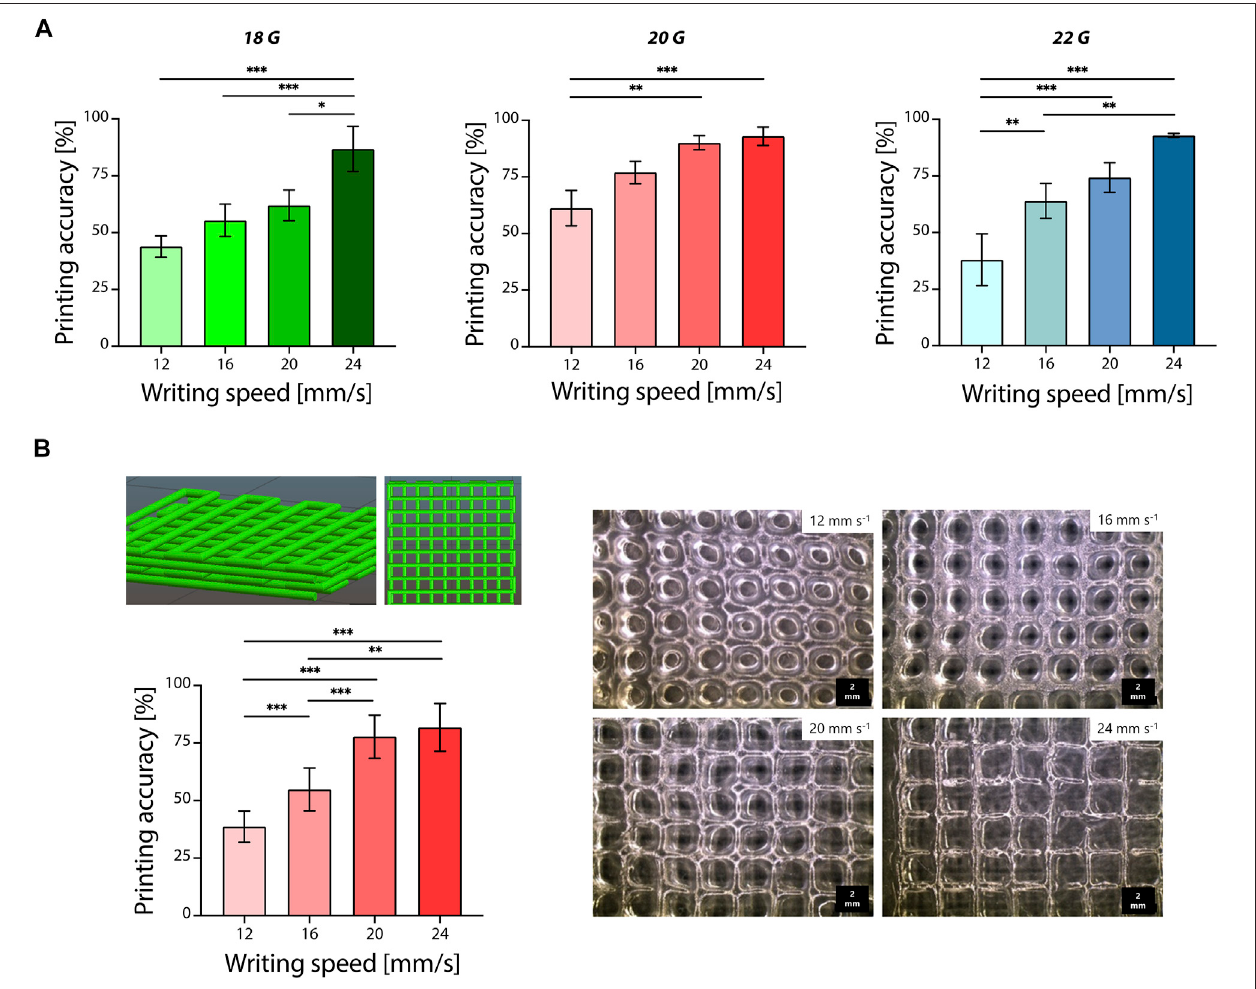
FIGURE 2 | Optimization of pectin-TOCNFs inks 3D printing. (A) Printing accuracy evaluated by varying the nozzle size (18, 20, and 22 G) and writing speed (12, 16,20,and24 mm/s);* p < 0.05;** p < 0.01;*** p < 0.001. (B) Optimizationoftheprintingof3Dgridstructuresbyvaryingthewritingspeed(12,16,20,and24 mm/s, left ) and microscopy images of the obtained 3D printed structures (scale bar (cid:1) 2 mm, right ); ** p < 0.01; *** p < 0.001.